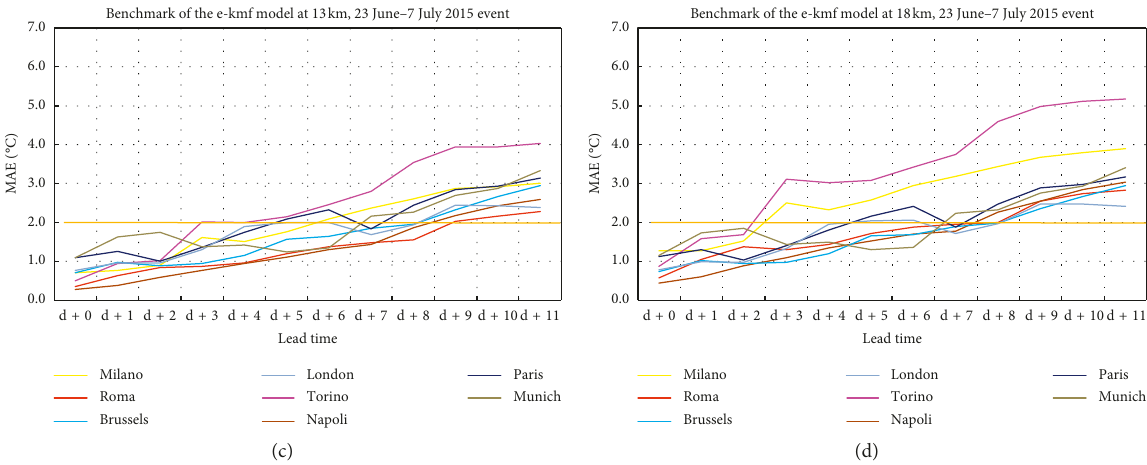
Figure 6: Comparison of the MAE for the 23 June–7 July 2015 episode between the e-kmf ™ model at different grid resolutions over all the analysed cities from day+0 to day+ 11 as lead time of